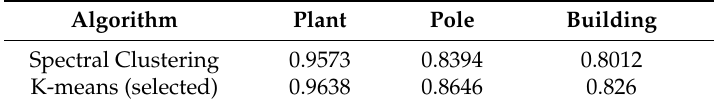
Table 4. The Average Precision (AP) comparison of two unsupervised methods.